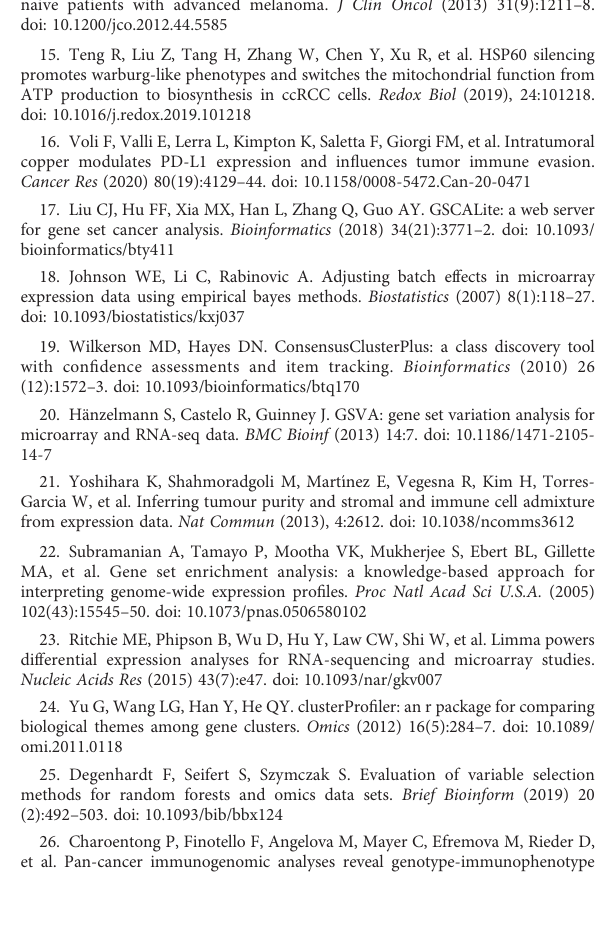
SUPPLEMENTARY FIGURE 5 Clinical subgroup analysis of CUS in KIRC. (A – G) Finding the relationship between six clinical features and CUS by difference comparison and ratio distribution: fustat (A) , Grade (B) , T_stage (C) , N_stage (D) , M_stage (E) and Stage (F) . CUS, cuproptosis score.